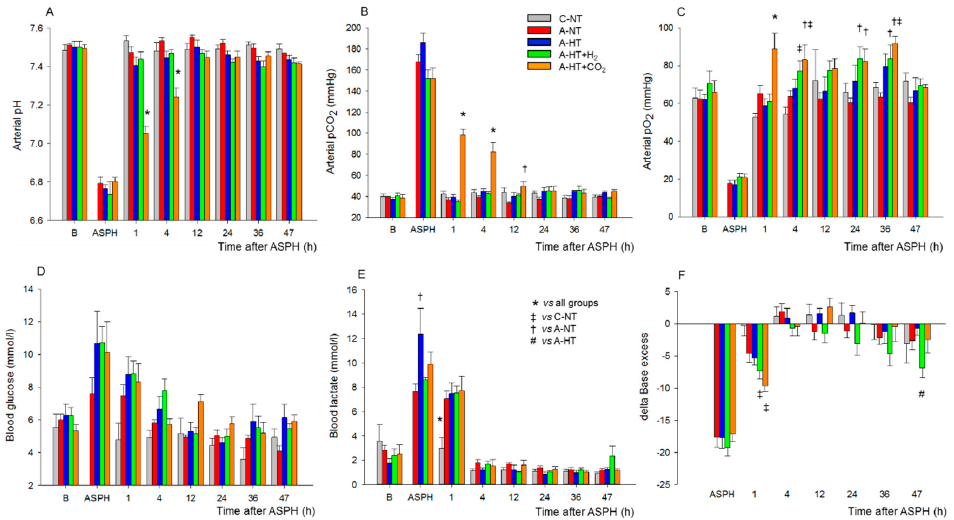
Figure 3. Blood chemistry data at baseline ( B ), in the last minute of 20 min asphyxia (ASPH), and the subsequent observation period. Arterial blood gas analysis revealed that asphyxia resulted in severe acidosis ( A ), hypercapnia ( B ), hypoxemia ( C ). Plasma glucose ( D ) and lactate levels ( E ) were markedly